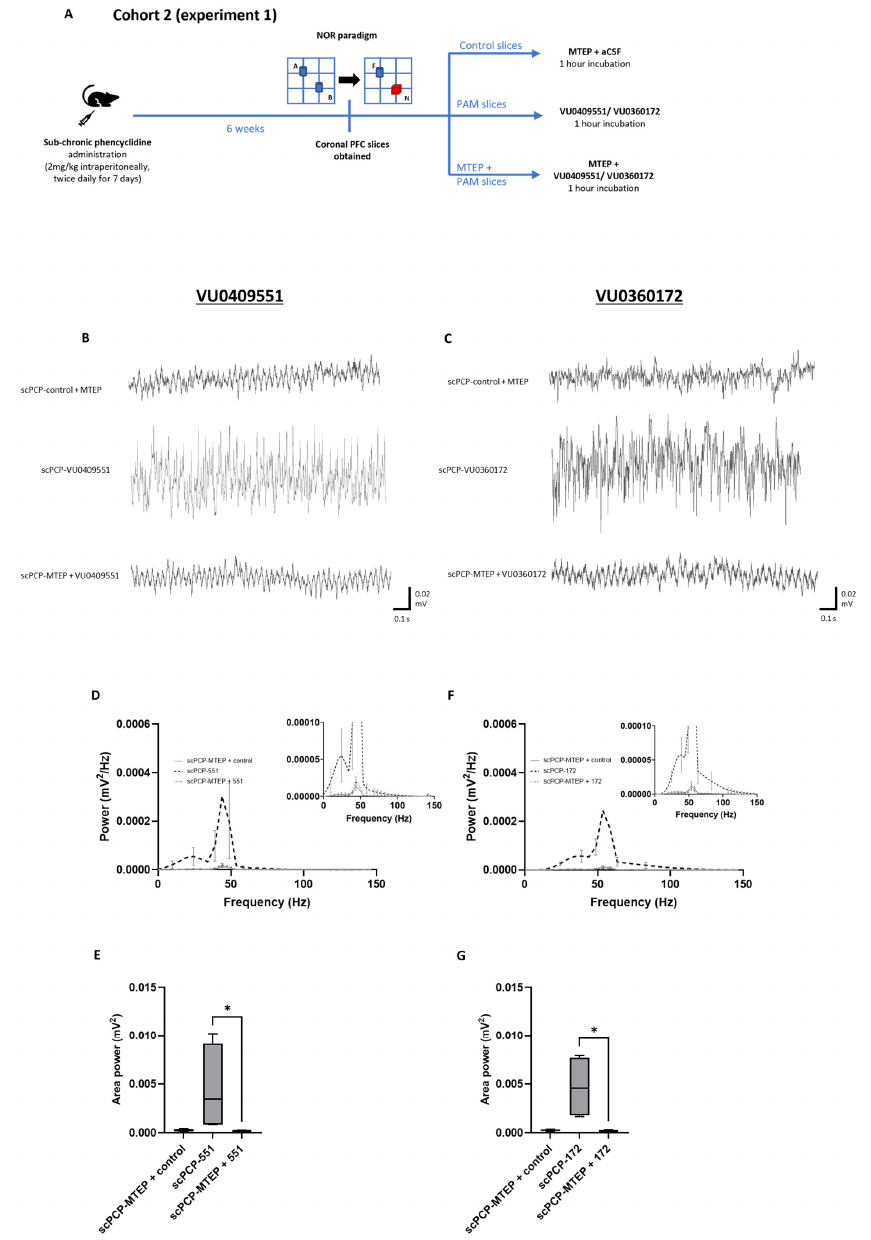
Figure 5. The mGlu5 receptor antagonist, MTEP prevents the restorative effects of VU0409551 or VU0360172 on scPCP slices in terms of gamma power. ( A ) Schematic illustrating the experimental protocol for Cohort 2, experiment 1. A, B, blue; identical objects. F, blue; familiar object. N, red; novel object. ( B , C ) Representative traces showing oscillatory activity in PFC slices from scPCP-treated rats without PAM application with MTEP alone (scPCP-control + MTEP), and scPCP slices treated with MTEP followed by VU0409551 or VU0360172. The MTEP was present during PAM incubation but was washed off before oscillations were evoked. Power spectral analyses show the effect of MTEP alongside ( D ), VU0409551, and ( F ), VU0360172 on amplitude power ( n = 4 per group, analysed using a Friedman’s test followed by Dunn’s tests). Graph insets more clearly illustrate data in low power ranges. Box plots show the median (whiskers max–min) area power in slices incubated in ( E ), VU0409551 ( n = 4 per group) or ( G ), VU0360172 ( n = 4 per group; both analysed using Friedman’s tests followed by Dunn’s tests; * p < 0.05, significant decrease in area power compared to PAM incubation